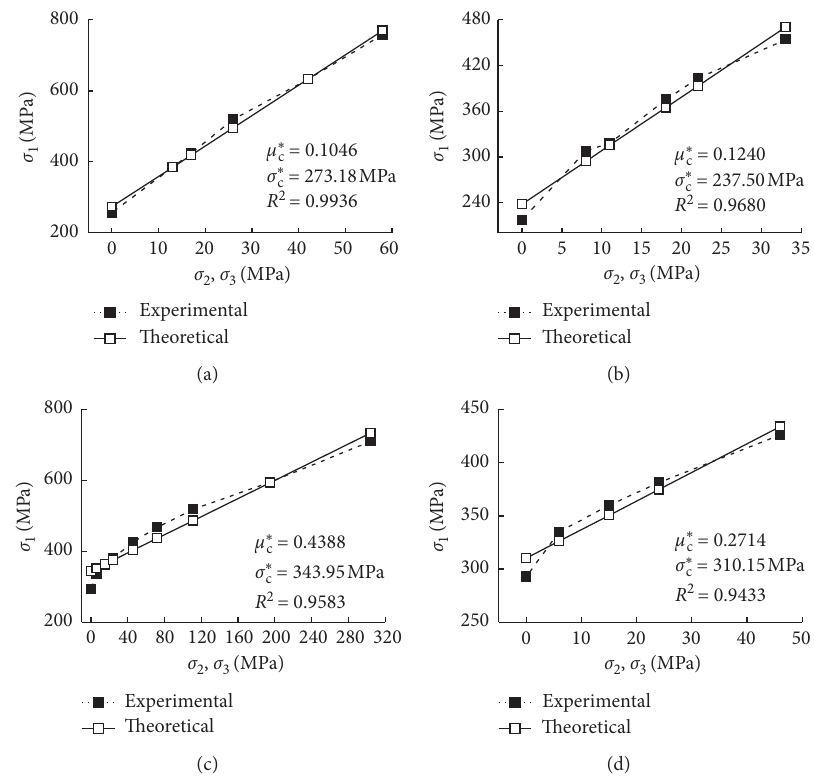
Figure 8: Conventional triaxial test data and theoretical results of (a) Westerly granite, (b) Dunham dolomite, (c) Solnhofen limestone, and (d) Solnhofen limestone